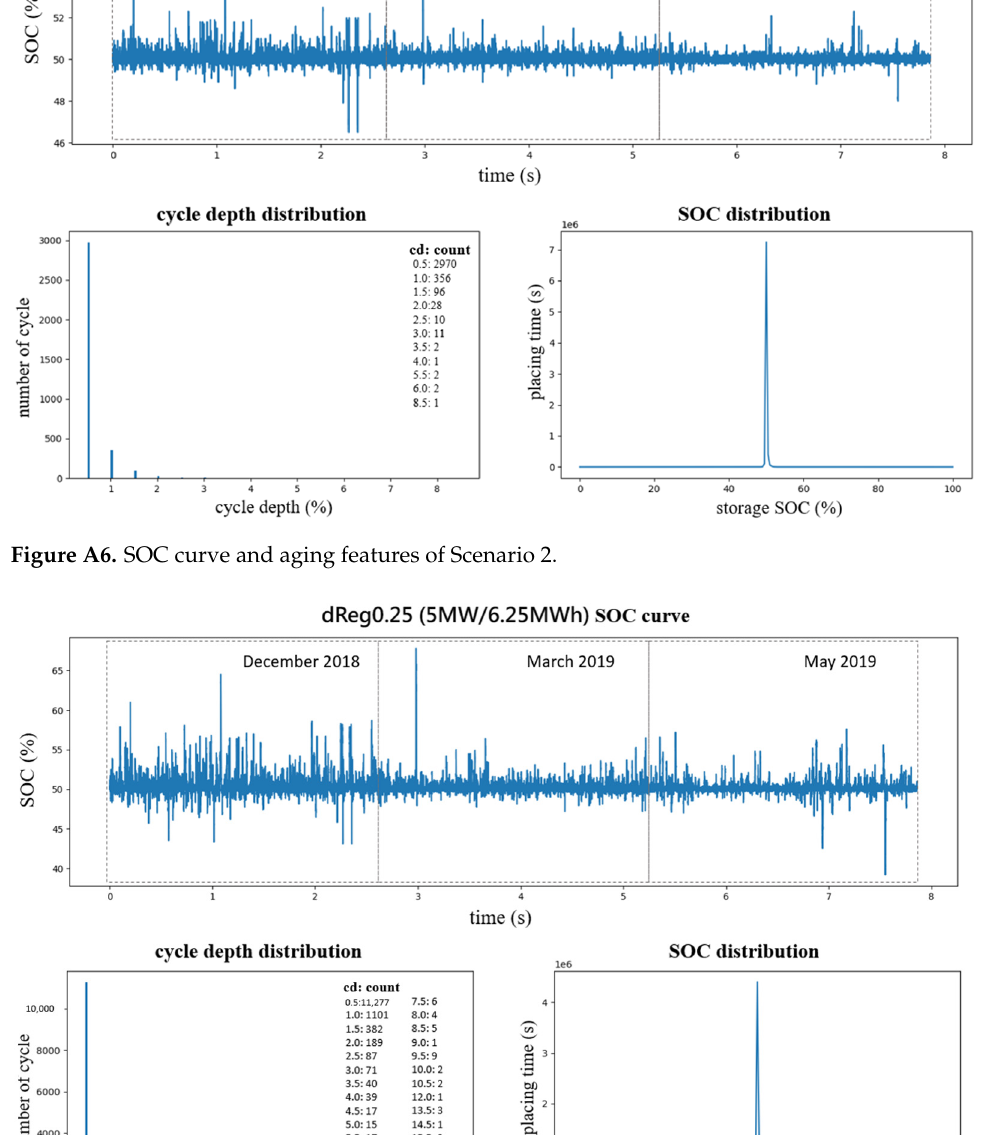
Figure A8. SOC curve and aging features of Scenario 7. References 1.